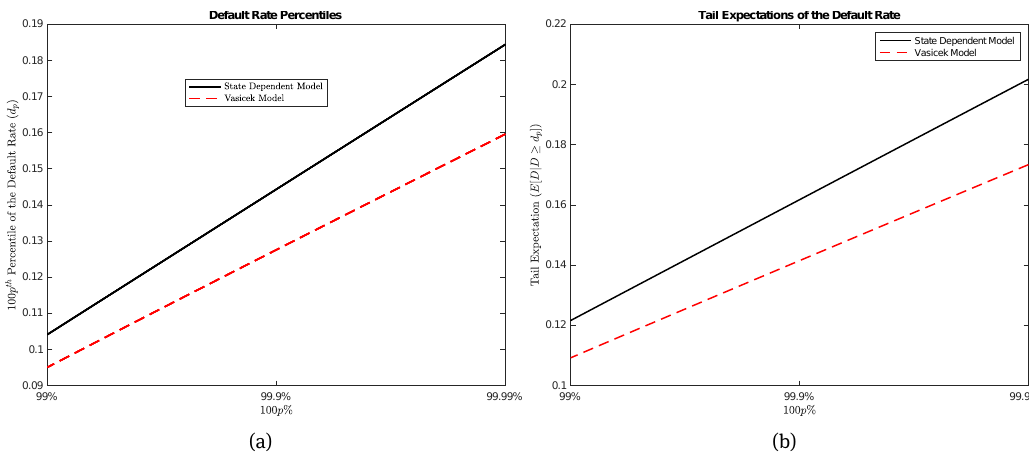
Figure 4.5: Panel (a) illustrates percentiles of the large-portfolio default rate in our numerical example. The 100 p th percentile is denoted d p and satisfies P ( D ≥ d p ) = 1 − p . In the Vasicek model d p = v x , a ( z 1− p ) , where z p is the 100 p th percentile of the standard Gaussian distribution. In the state dependent model d p is computed by numerically finding the root of the function d (cid:55)→ P ( D ≥ d )−(1− p ) , and we use (4.32) to compute P ( D ≥ d ) .. Panel (b) illustrates tail expectations E [ D | D ≥ d p ] . Quantiles are first computed as in panel (a), tail expectations are then computed using (4.34)